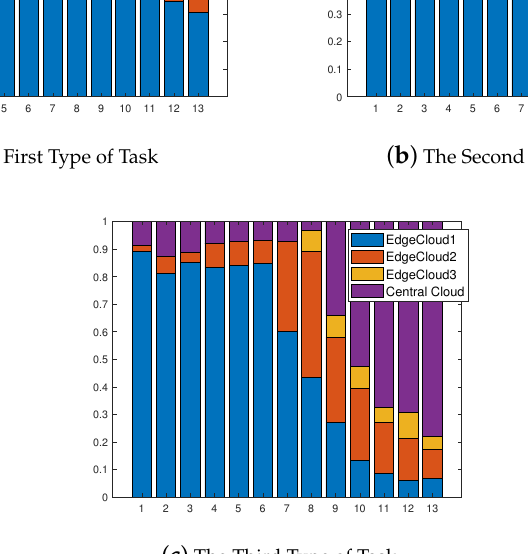
( c ) The Third Type of Task Figure 6. Dynamic Cloud Selection for Mobile Users in the Same Region.